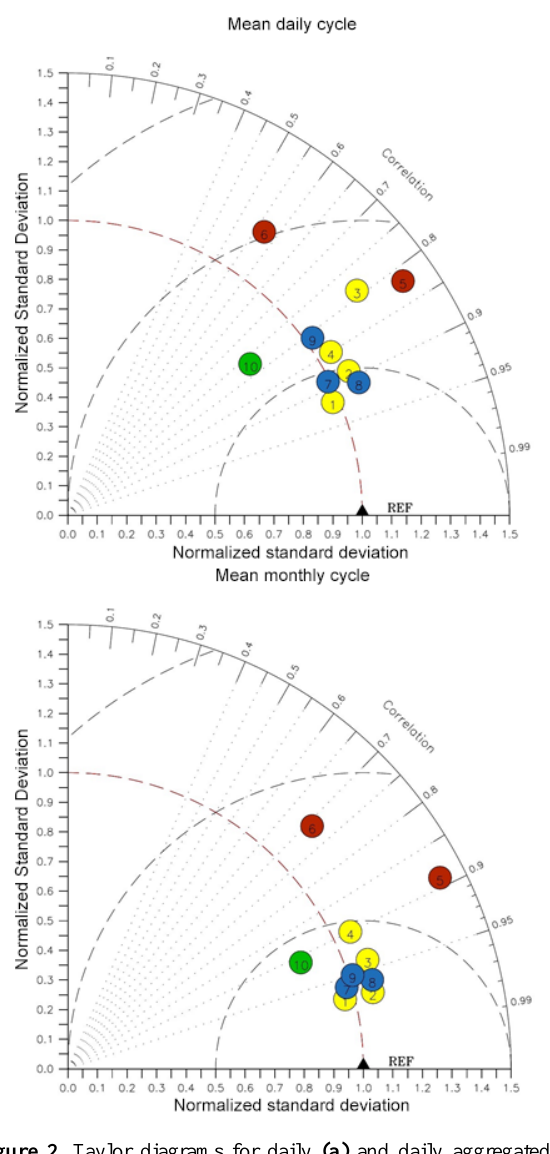
Figure 2. Taylor diagrams for daily (a) and daily aggregated to month (b) GPP evaluated representing: the deviation of model re- sults from observations in terms of normalized standard deviation of observations, represented by the distance from the site point to the point on the x axis identified as reference (REF); the difference of model normalized standard deviation from that of observations, rep- resented by the distance of the site point with respect to the quarter arc crossing REF; and the correlation, given by the azimuthal posi- tion of the site point to the x axis. The sites are numbered in ascend- ing order as follows: (1) DE-Hai, (2) DK-Sor, (3) FR-Hes, (4) IT- Col, (5) FR-Pue, (6) IT-Cpz, (7) DE-Tha, (8) FI-Hyy, (9) IT-Ren, (10) BE-Bra. Colours refer to different IGBP vegetation classes: DBF (yellow), EBF (orange), ENF (light-blue), MF (green).